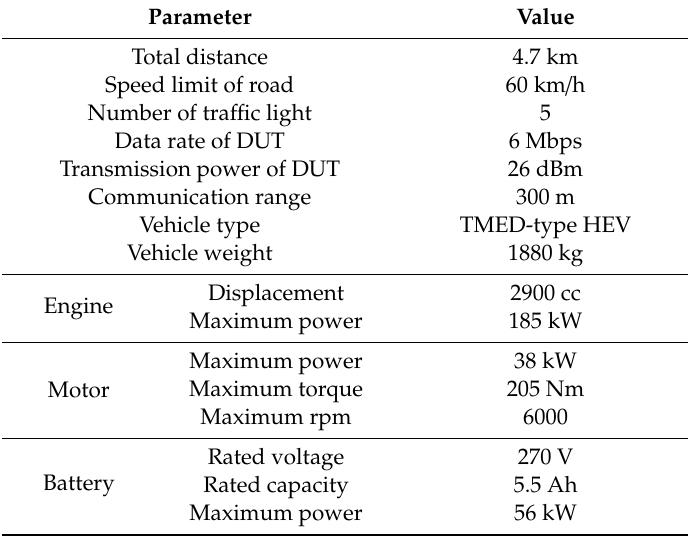
Table 1. Parameters in cooperative eco-driving speed guidance application